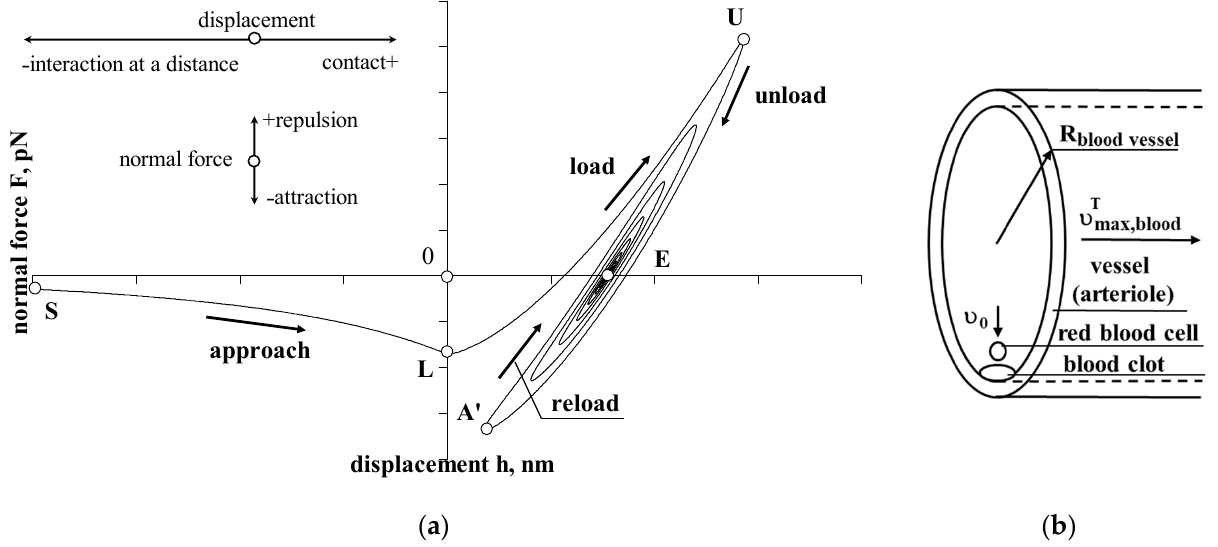
Figure 1. Sticking process model ( a ) and initial position of the erythrocyte ( b ). If it does not have enough kinetic energy to detach, reloading begins at point A’ and then the interaction ends at point E.